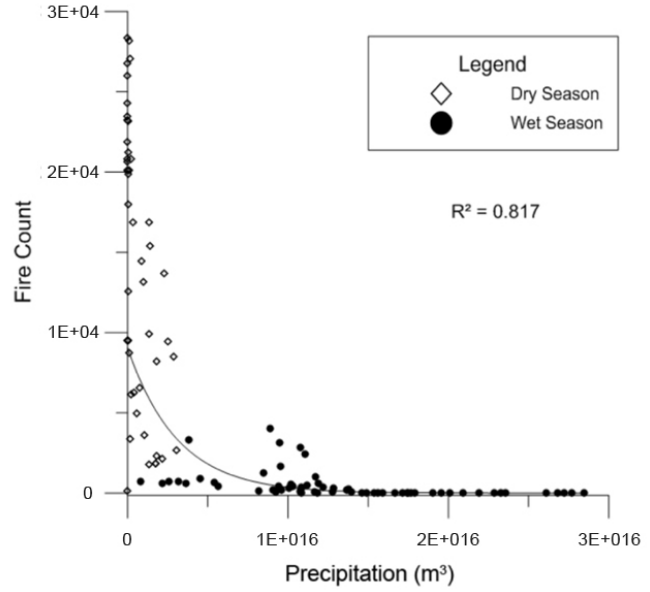
Figure 8. Scatter plot of monthly biomass burning count against precipitation from TRMM showing the demarcation between the wet season and dry season.